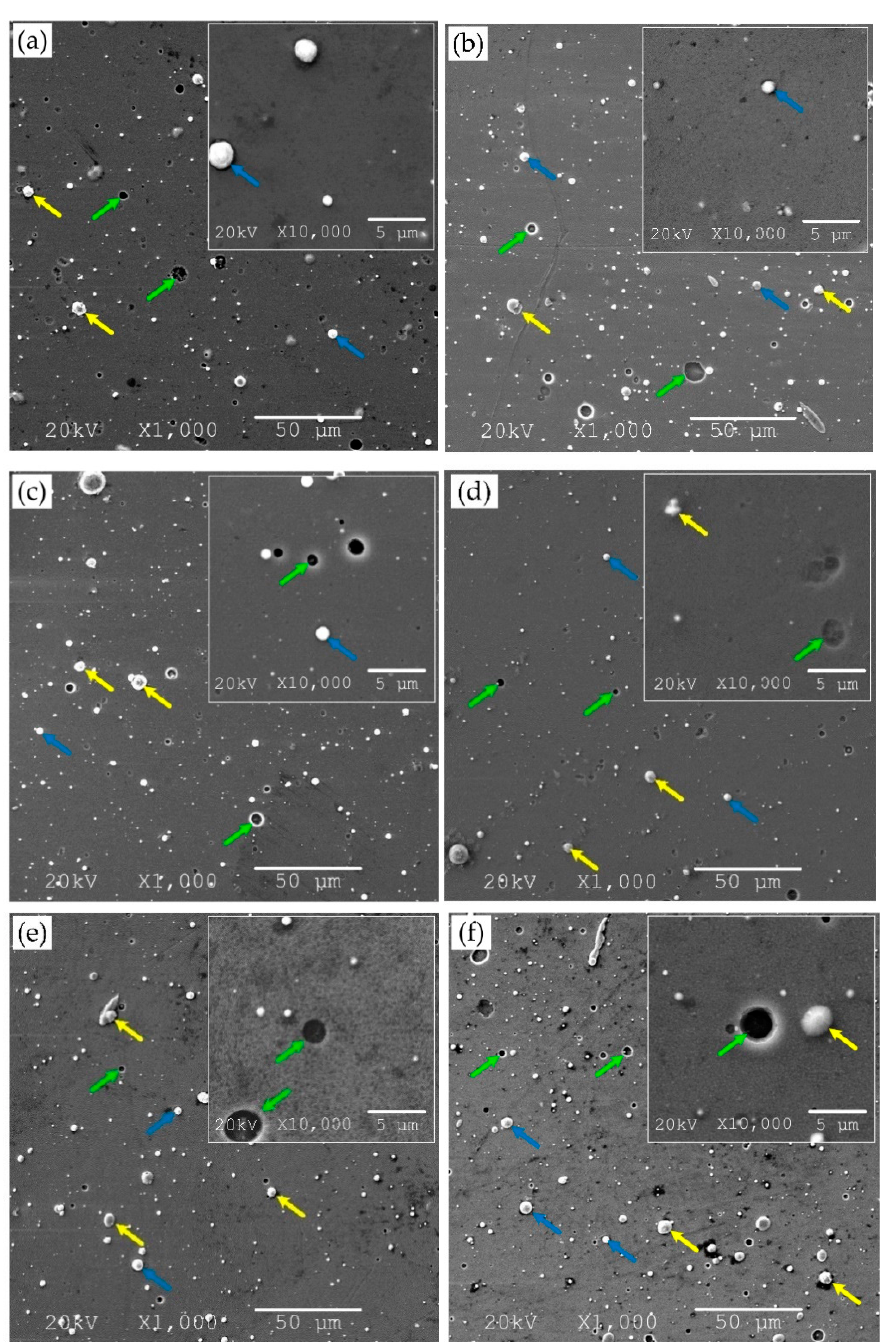
Figure 2. SEM micrograph of Zr-O-N coating morphology, magnification 1000× and 10,000×, the relative oxygen concentration O 2(x) : ( a ) 0%, ( b ) 10%, ( c ) 20%, ( d ) 30%, ( e ) 50%, ( f ) 100% with marked surface defects—macroparticles (yellow arrows), craters (green arrows), droplets (blue arrows).